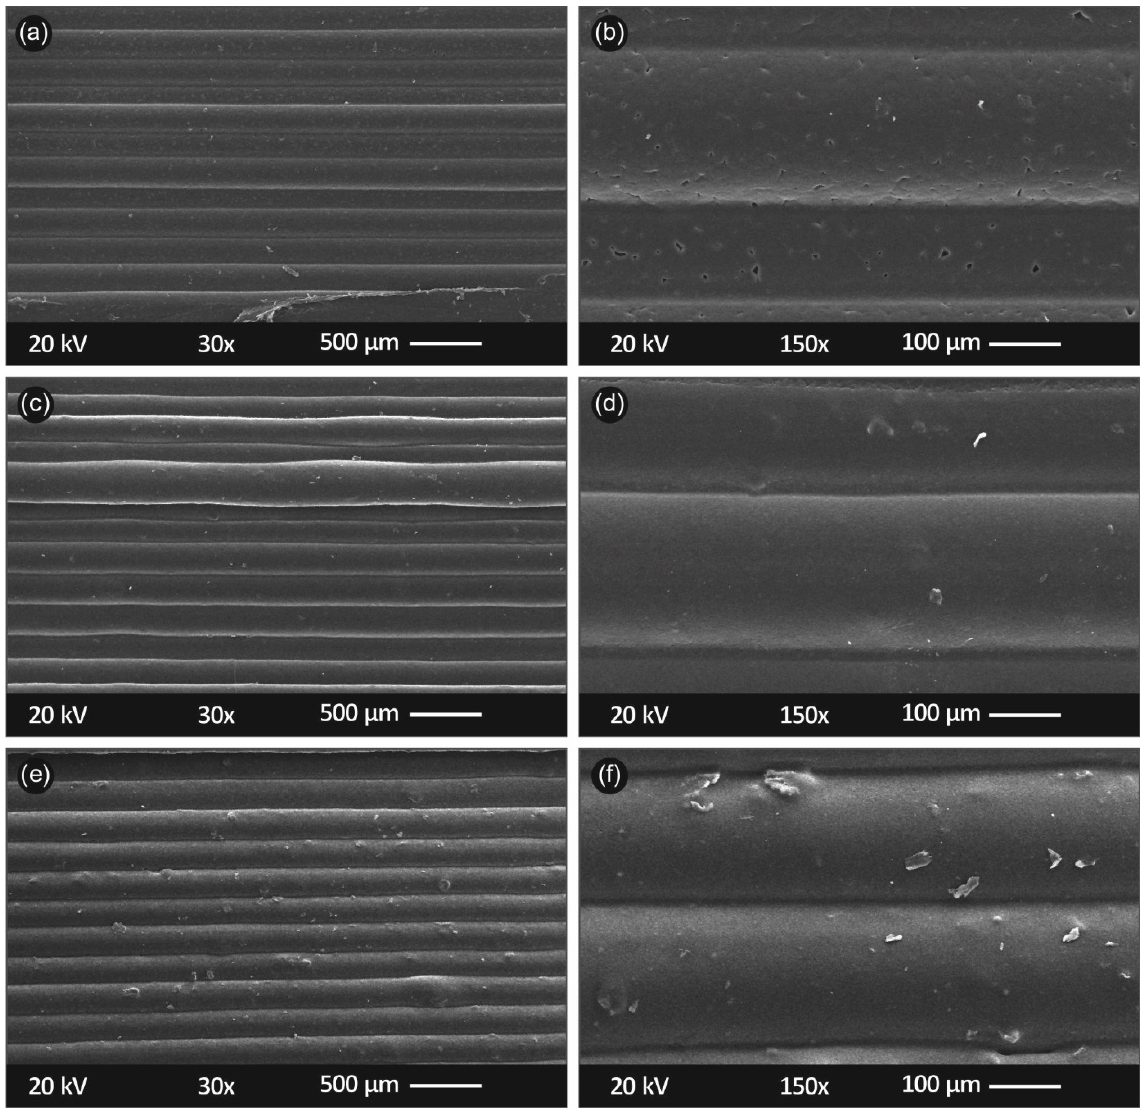
Figure 8. SEM images of the tensile specimens’ side/outer surfaces: ( a ) ×30 magnification of PP/SiO 2 0.5 wt.%; ( b ) ×150 magnification of PP/SiO 2 0.5 wt.%; ( c ) ×30 magnification of PP/SiO 2 2.0 wt.%; ( d ) ×150 magnification of PP/SiO 2 2.0 wt.%; ( e ) ×30 magnification of PP/SiO 2 4.0 wt.%; ( f ) ×150 magnification of PP/SiO 2 4.0 wt.%.